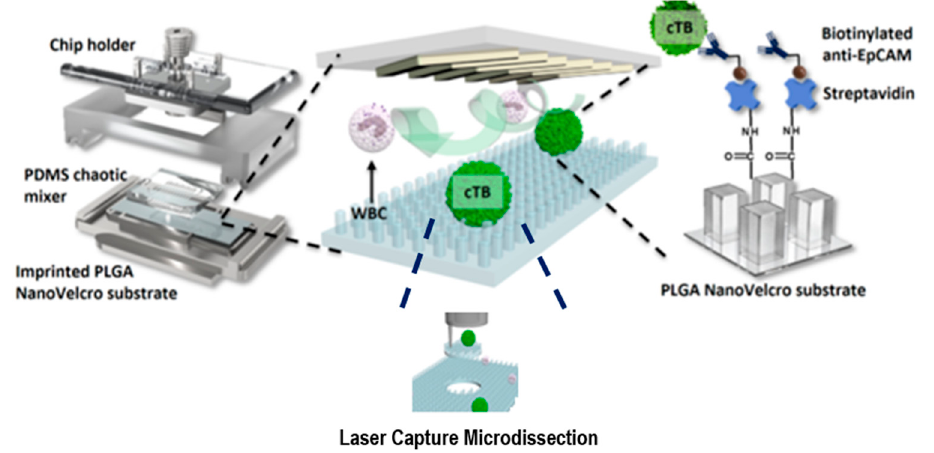
Figure 18. Anti-EpCAM functionalized nano Velcro microchip is assembled using a chip holder to hold together a chaotic mixer on top of an imprinted PLGA Nano Velcro substrate. “Reprinted with permission from [151]. Copyright (2017) American Chemical Society.”